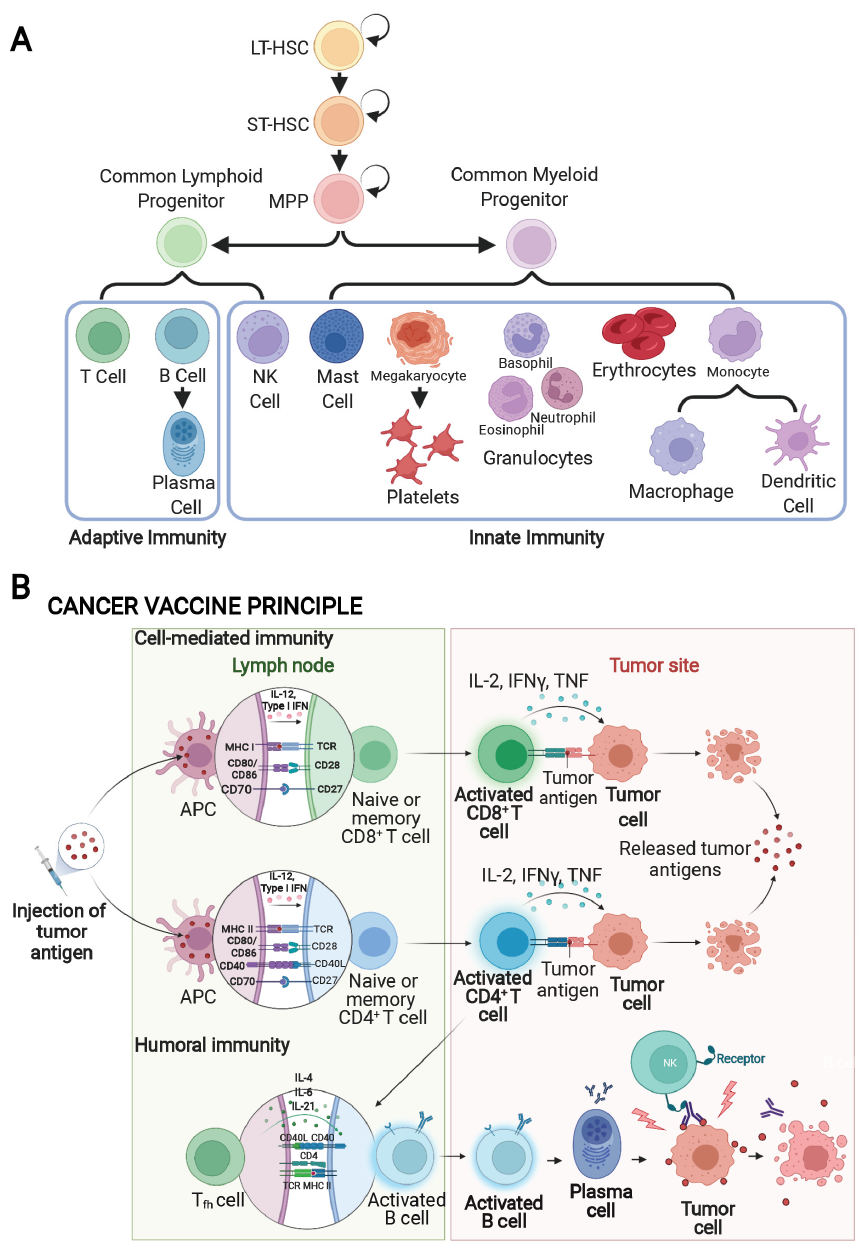
Figure 1. Innate versus adaptive immunity and the mechanisms by which cancer vaccines activate the immune system. ( A ) The schematic shows the hierarchy of hematopoietic lineage commitment, divided into innate versus adaptive immunity. Created using “Immune & Blood Cells”, by BioRender.com (2022). Retrieved from https://app.biorender.com/categories/cell-types/ (accessed on 26 January 2022). LT-HSC, long-term hematopoietic stem cell; MPP, multipotent progenitor; NK cell, natural killer cell; ST-HSC, short-term hematopoietic stem cell. ( B ) The schematic shows multiple mechanisms by which cancer vaccines activate the immune system, both in the tumor site and within the lymphatic system, divided into cell-mediated versus humoral immunity. Adapted from “Cancer Vaccine Principle” by BioRender.com (2022). Retrieved from https://app.biorender.com/biorender-templates (accessed on 26 January 2022). APC, antigen-presenting cell; CD, cluster of differentiation; IFN, interferon; IL, interleukin; MHC I, major histocompatibility complex I; MHC II, major histocompatibility complex II; T fh , CD4 + T follicular helper cells; TNF, tumor necrosis